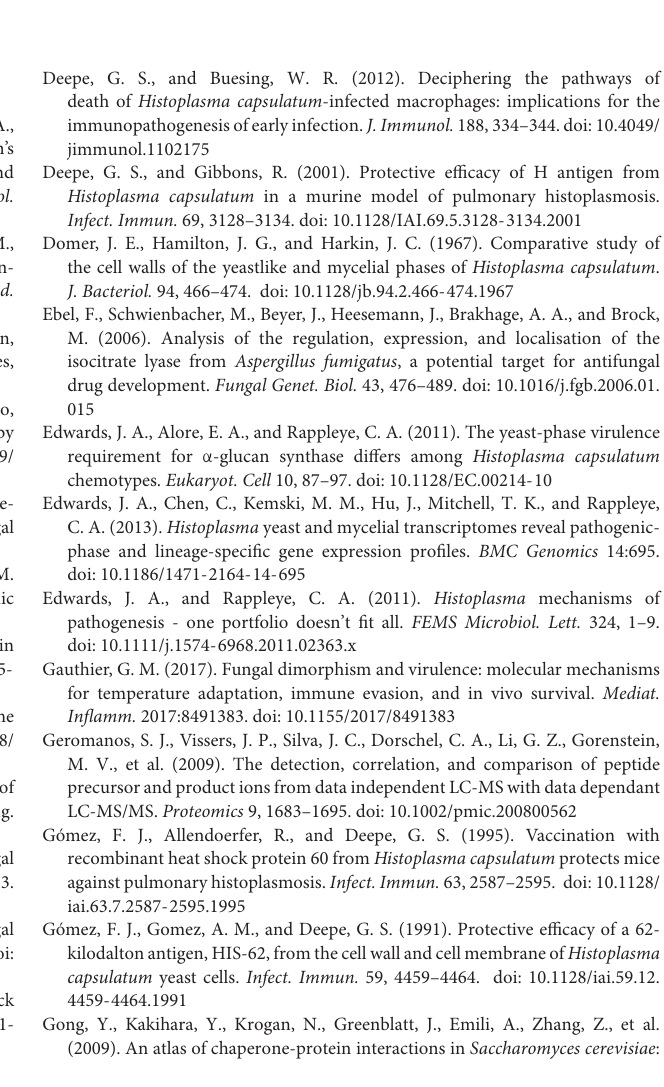
Supplementary Figure 3 | Experiment parts per million (ppm) error at the peptide level. The graphs indicate the identified peptides number in ppm. A total of 91.8 and 91.4% identified peptides were detected with an error of less than 10 ppm in yeast (A) and mycelium (B) forms. Supplementary Figure 4 | Detection dynamic range of proteomic analysis. Graphs for yeast (A) and mycelium (B) were generated, presenting proteins identified in a regular way (red), reverse (blue), and the rabbit phosphorylase B was the external standard (yellow). Supplementary Table 1 | Identified proteins from Histoplasma capsulatum in mycelium. Supplementary Table 2 | Identified proteins from Histoplasma capsulatum in yeast